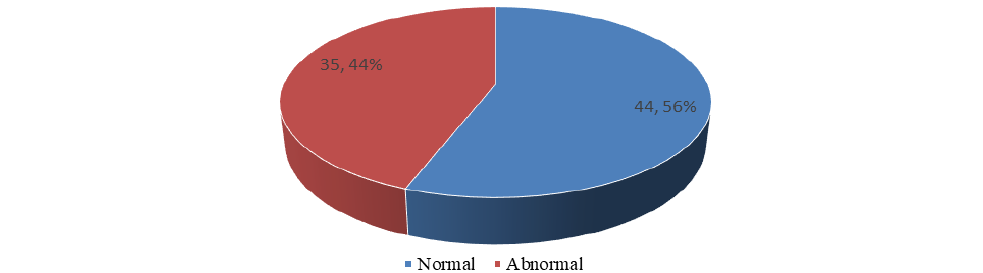
Figure 1. Prevalence of men with normal and abnormal sperm parameters amongst study population Seminal fructose and citric acid levels amongst men with normal and abnormal sperm parameters